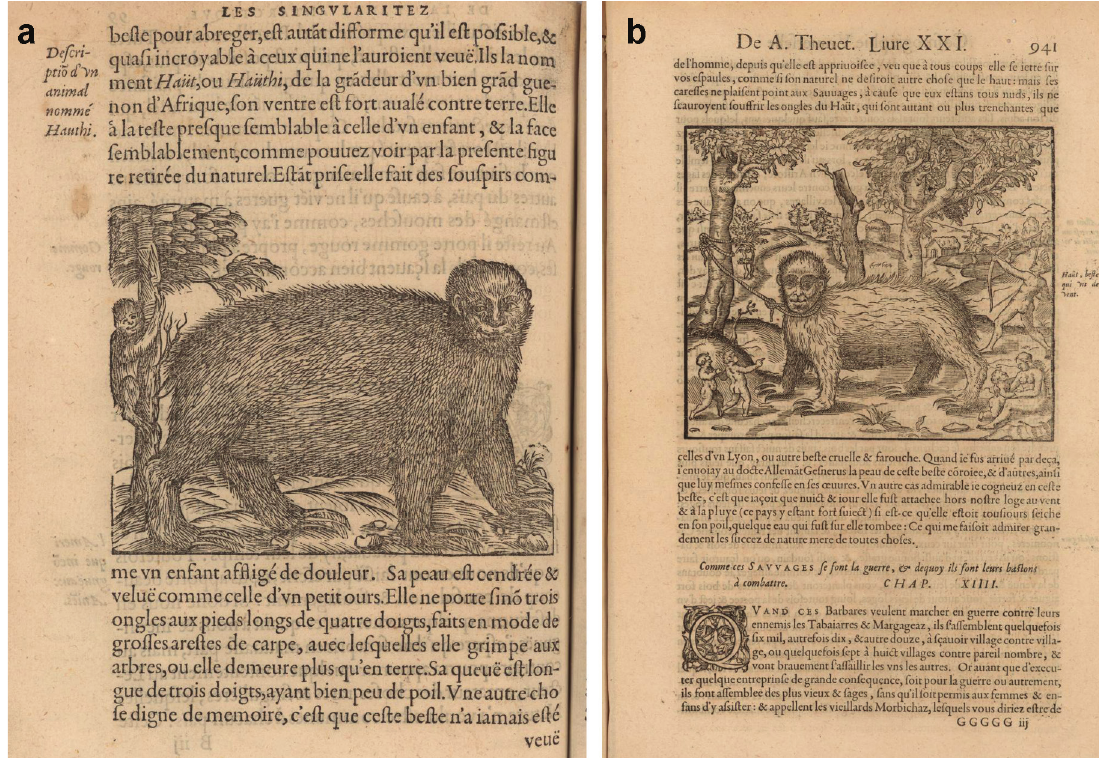
Figure 2 - Bradypus ( haüthi ). Drawings of andré Thevet in his books (a) Les Singularitez de la France antarctique, autrement nommée Amerique, & de plusieurs Terres & Isles decouvertes de nostre temps (1558, leaf 99) and (b) Cosmographie Universelle (1575, leaf 941). Courtesy of the John Carter Brown library at Brown University.